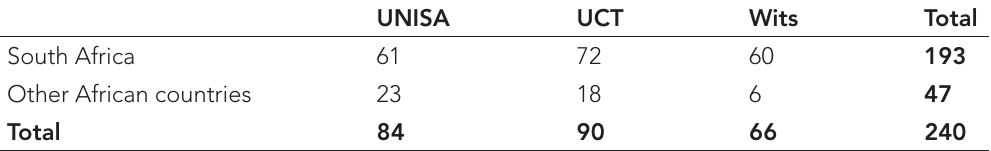
Table 2: Number of South African academics on the editorial boards of journals that include African